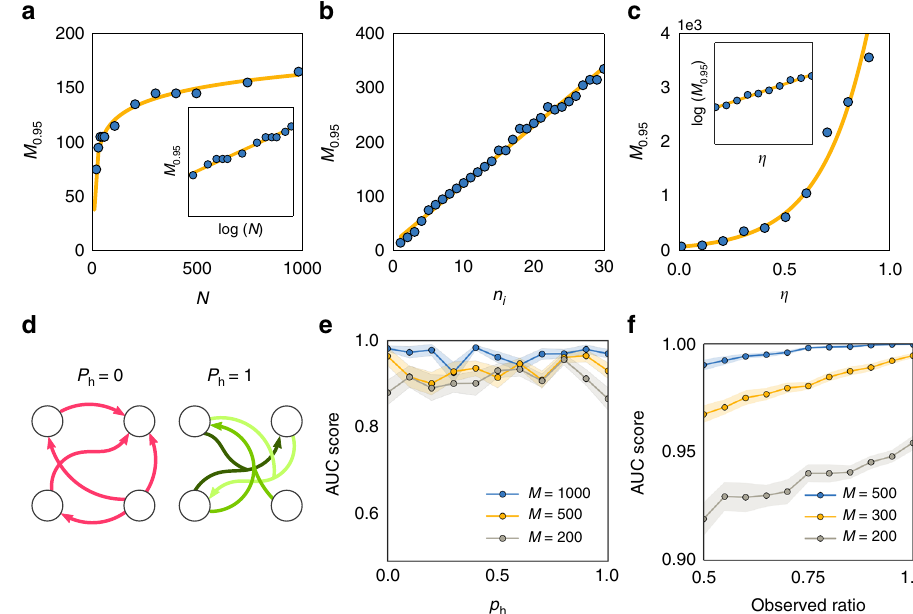
Fig. 4 Performance on networks and hypernetworks. a Minimum length M 0.95 of time series required for achieving AUC score > 0.95 versus the number of units N with a logarithmic fi t. The inset shows the same data with N on logarithmic scale. The number of incoming interactions n i = 10 was fi xed for all networks. b M 0.95 versus n i with a linear fi t, for networks of fi xed size N = 50. c M 0.95 versus standard deviation of noise level η with a exponential fi t. The inset shows the same data with M 0.95 on logarithmic scale. d Cartoon of networks with p h = 0 and p h = 1. e Systematic reconstructions of hypernetworks of N = 20 phase-coupled oscillators for varying p ∈ [0, 1] and M ∈ {200, 500, 1000} and fi xed n i = 5. f Systematic reconstructions of networks of N = 20 ( n i h = 10) units versus the fraction of observed (non-hidden) units